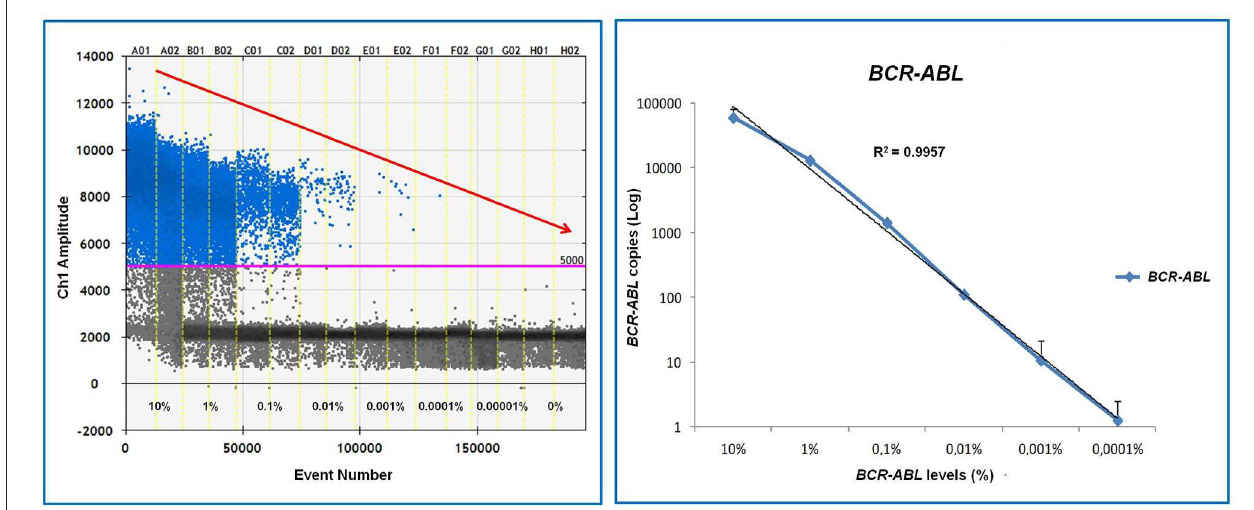
FIGURE 5 | Assessment of detection performance of dPCR system in RNA samples obtained from serial dilutions of Ph’ + cells in Ph’-cells. As shown, dPCR is able to detect BCR-ABL1 mRNA up to 0.001%